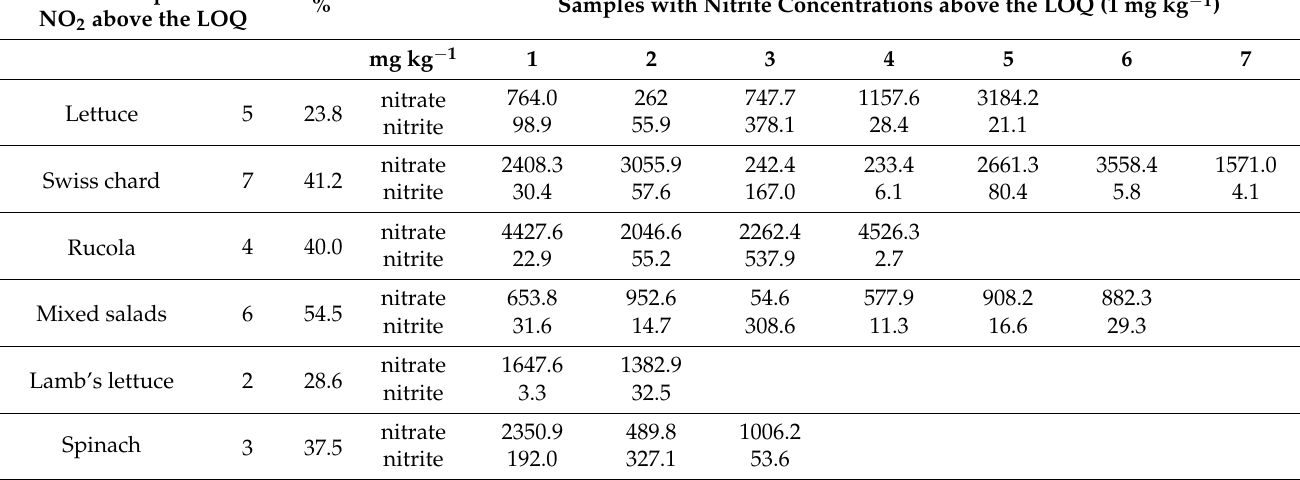
Table 3. Prevalence of the nitrite concentrations with accompanying nitrate concentrations in these